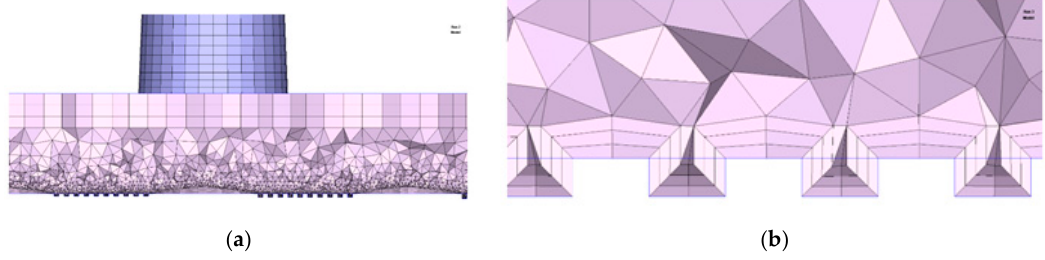
Figure 4. Meshing of ( a ) the part and ( b ) details of the elements in the microstructures.